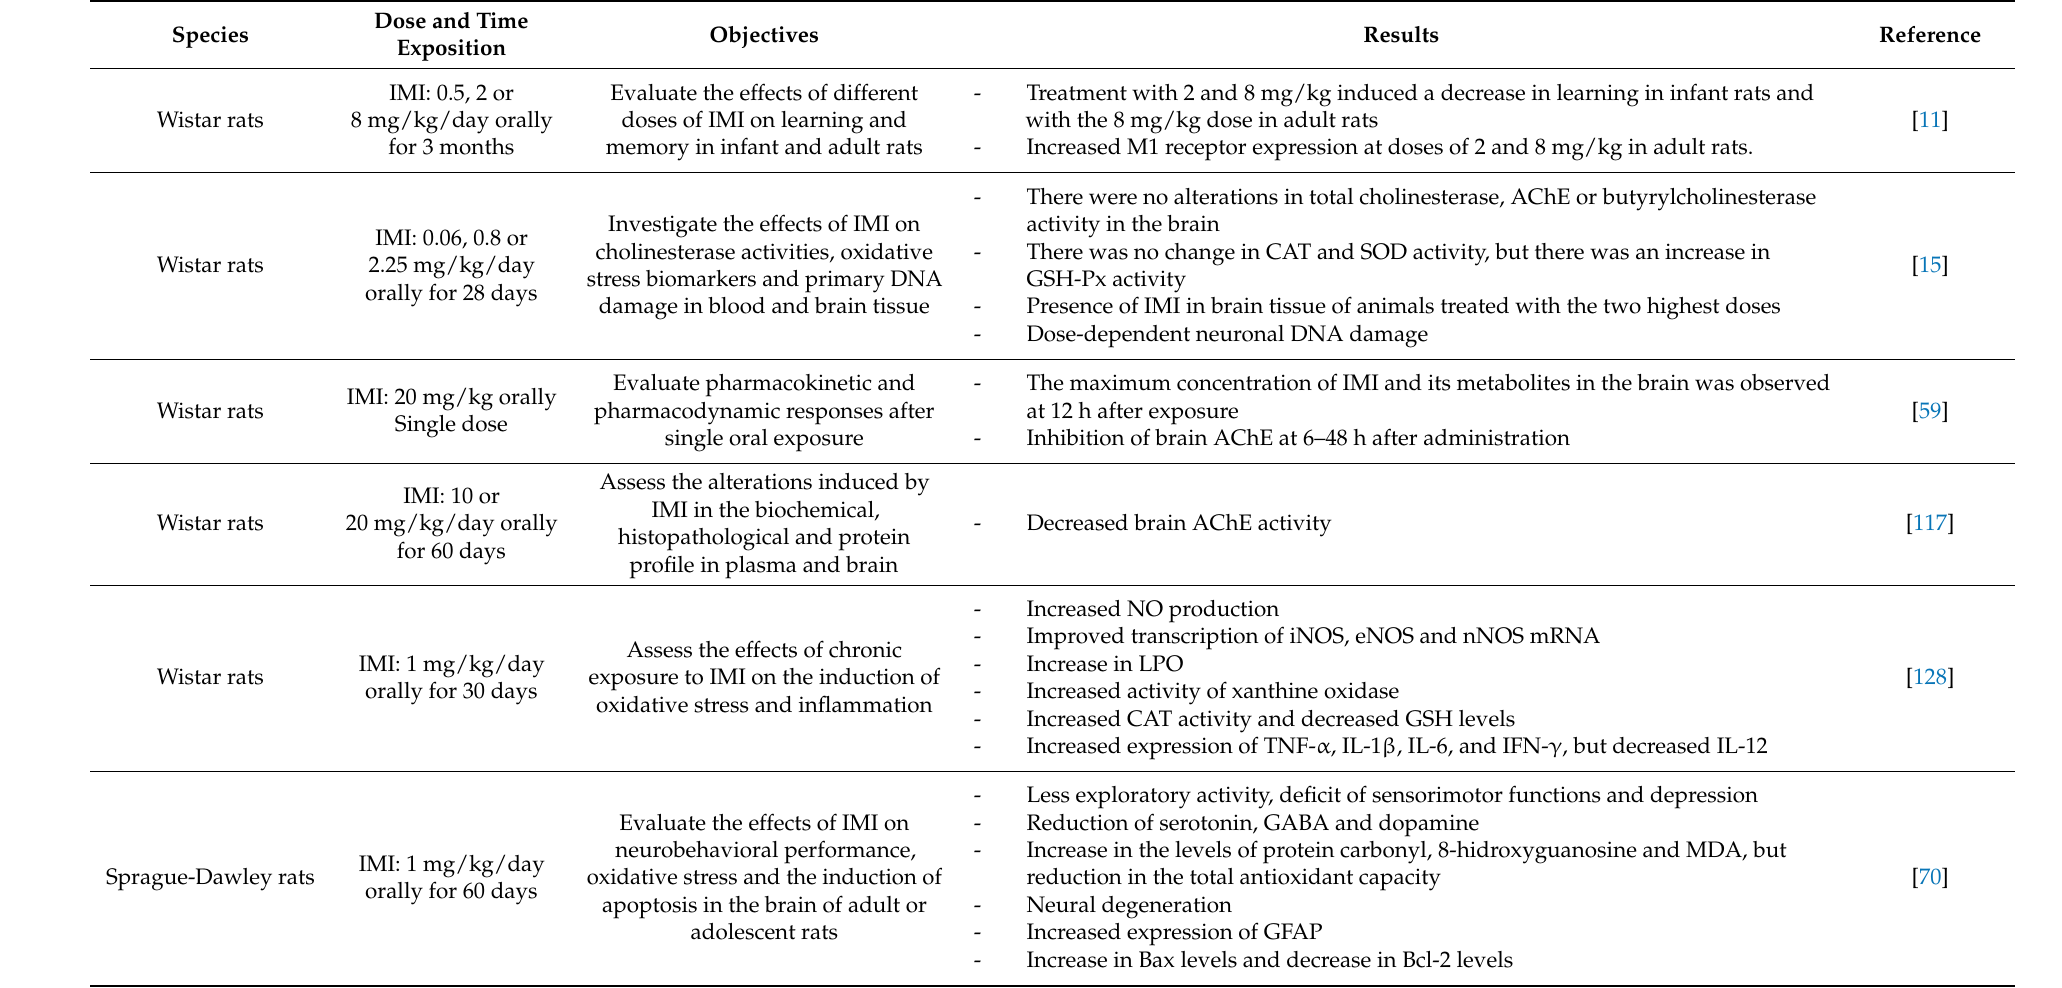
Table 1. Neurotoxic effects derived from in vivo exposure to neonicotinoid pesticides in